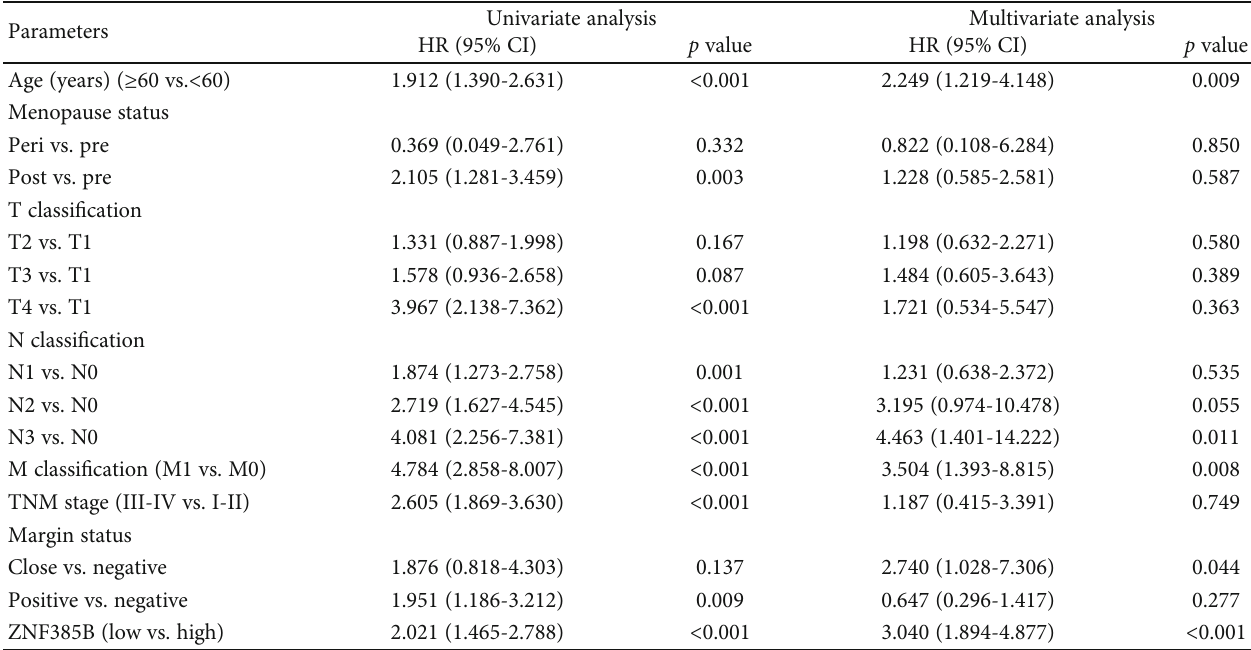
Table 3: Univariate and multivariate Cox regression analyses of various prognostic parameters of overall survival in patients with breast